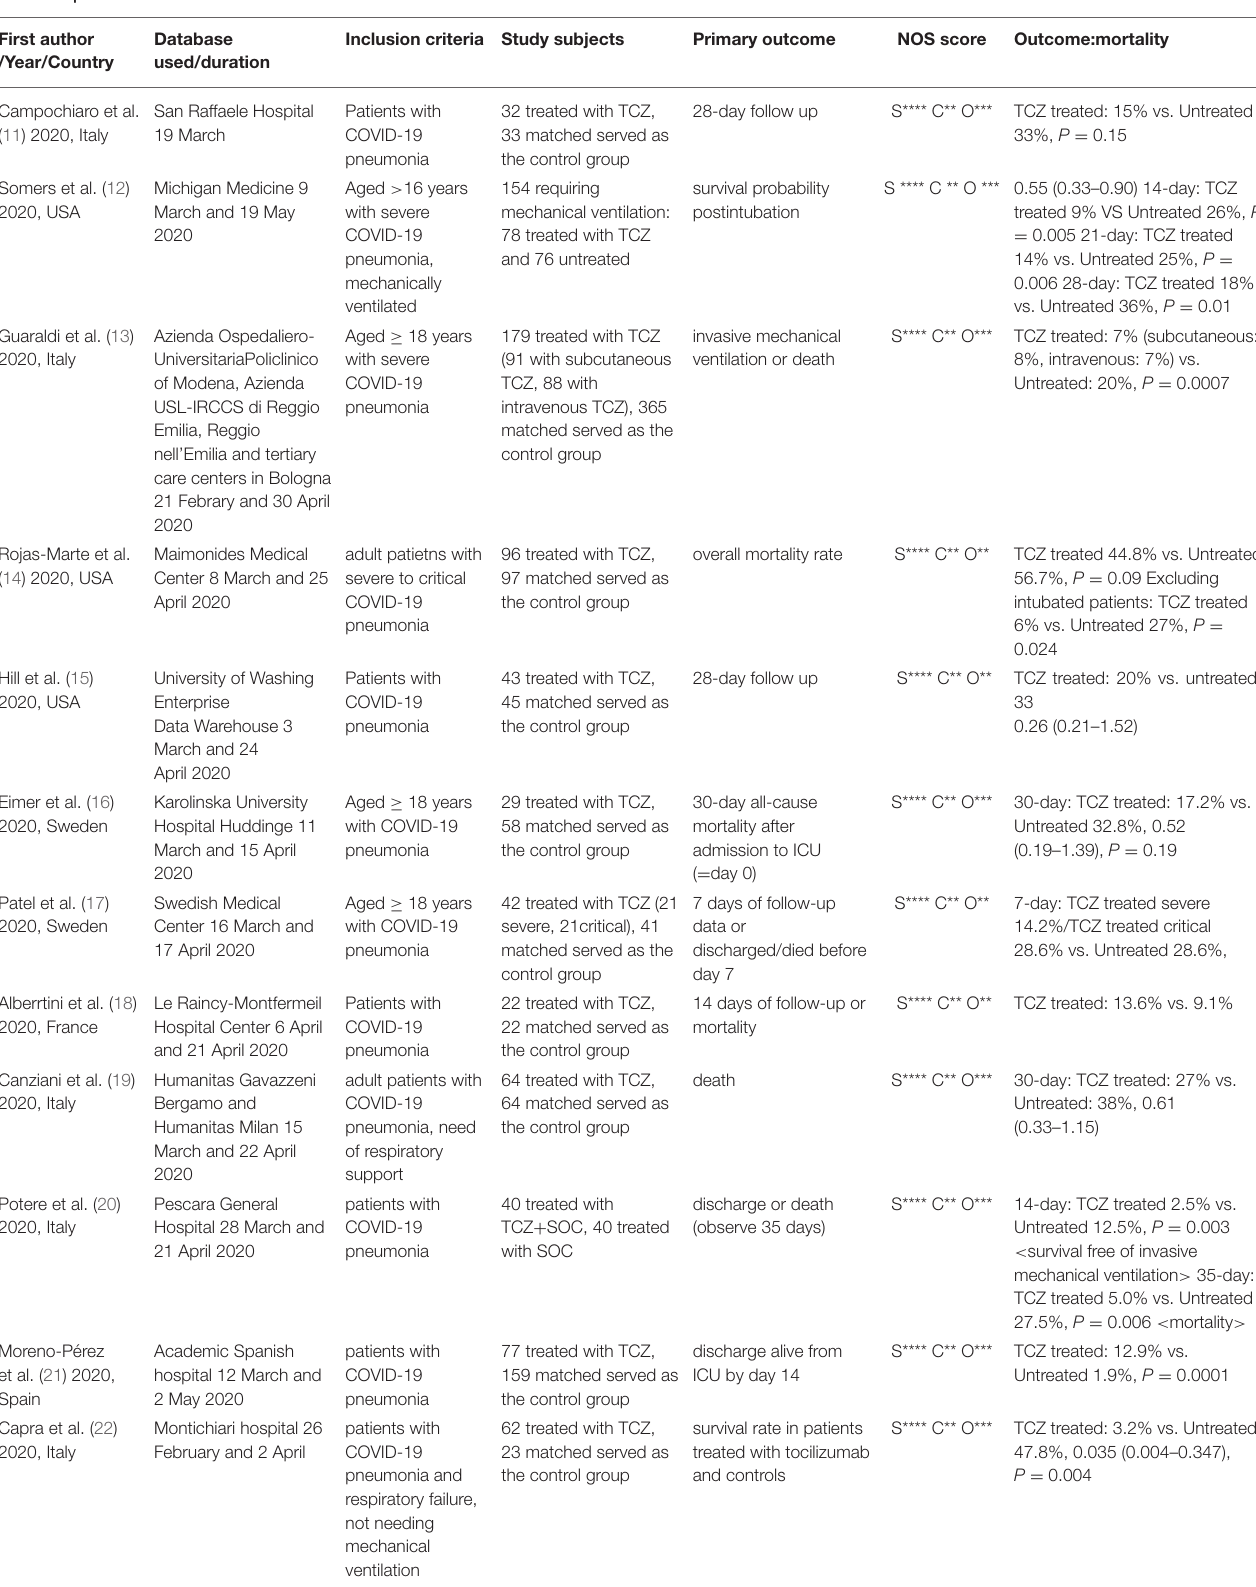
TABLE 2 | Characteristics of included